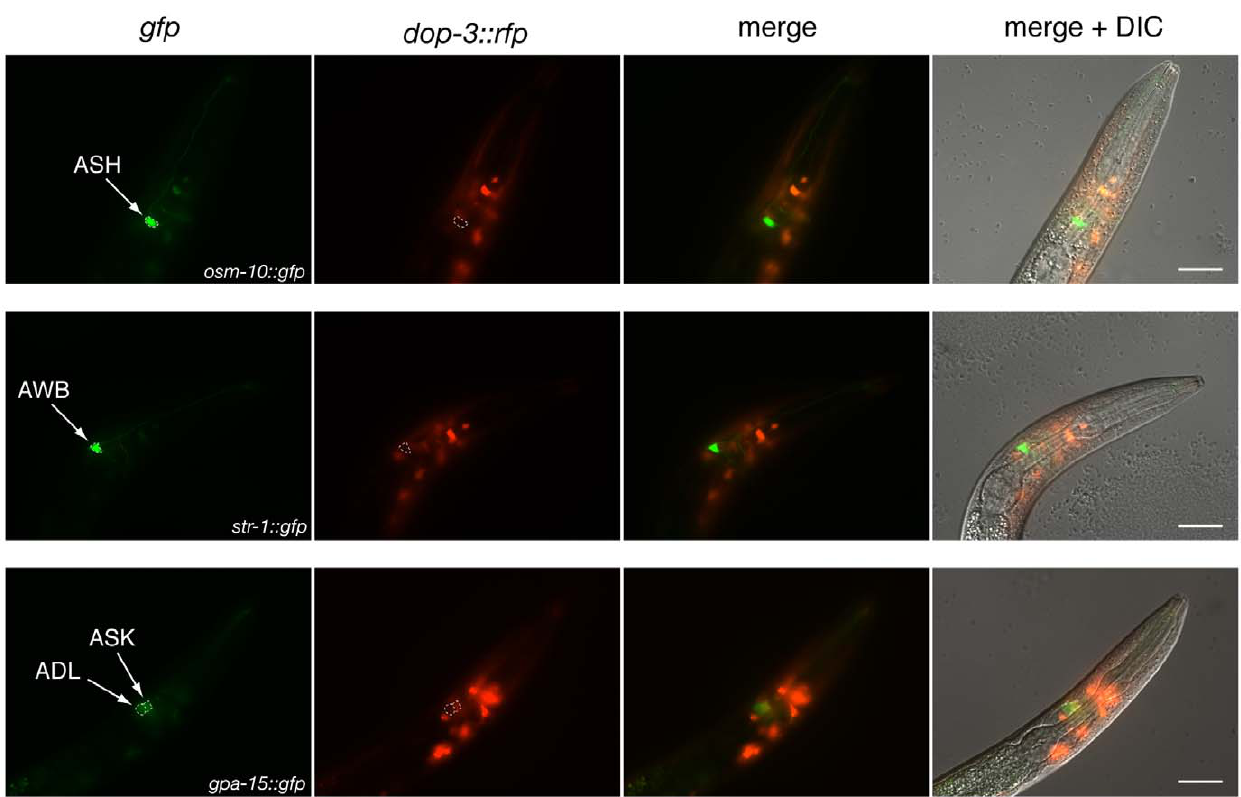
Figure 6. DOP-3::RFP expression is not seen in the sensory neurons that detect octanol. The ASH sensory neurons are the primary sensors of 100% octanol when animals are assayed on food, and only ASH is used to detect diluted octanol both on and off food [19]. The integrated transgene vsIs33 encodes 13,035 base pairs of dop-3 genomic DNA, including 9,955 base pairs of upstream promoter sequence and extending into the fourth coding exon [25]. This sequence is fused to the mRFP1 red fluorescent protein [25,75]. DOP-3::RFP expression was not observed in ASH (marked by osm-10::gfp ), or the other octanol-detecting neurons, AWB (marked by str-1::gfp ) or ADL (marked by gpa-15::gfp ). Weak expression was often observed in ASK (marked by gpa-15::gfp ). Scale bar =20 m m.